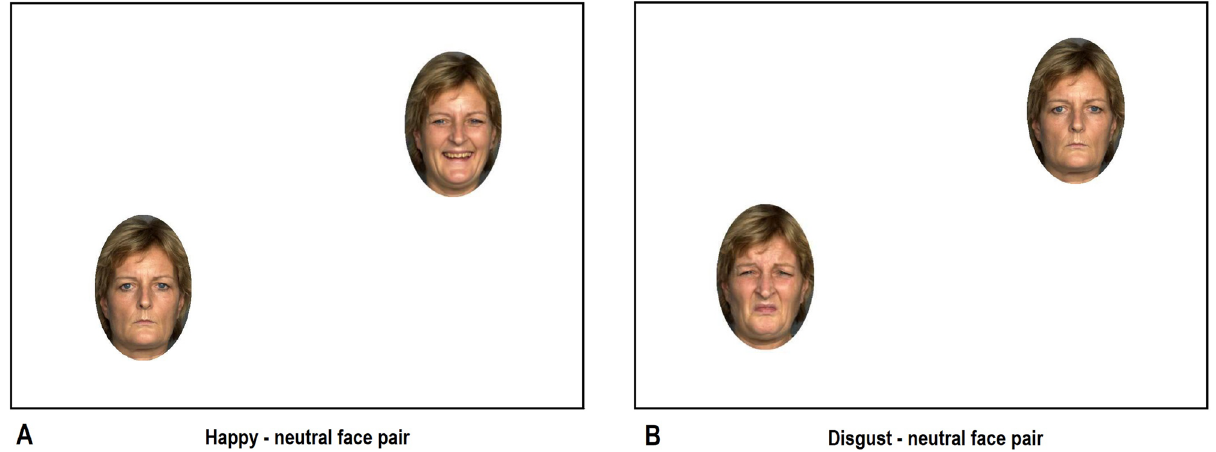
Figure 6. Examples of pairs of facial expressions presented in the dot-probe